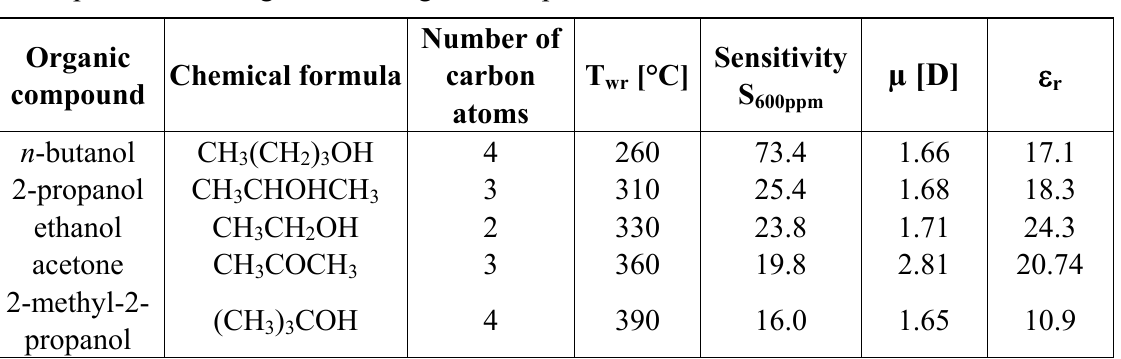
) and sensitivity (S ) of gas sensors in the wr 600ppm